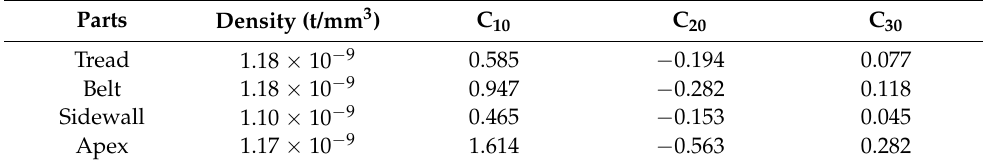
Figure 2. Tire FEM: ( a ) 3D FEM of tire; ( b ) Tire model coupling with acoustic medium. Table 1. Rubber material parameters in